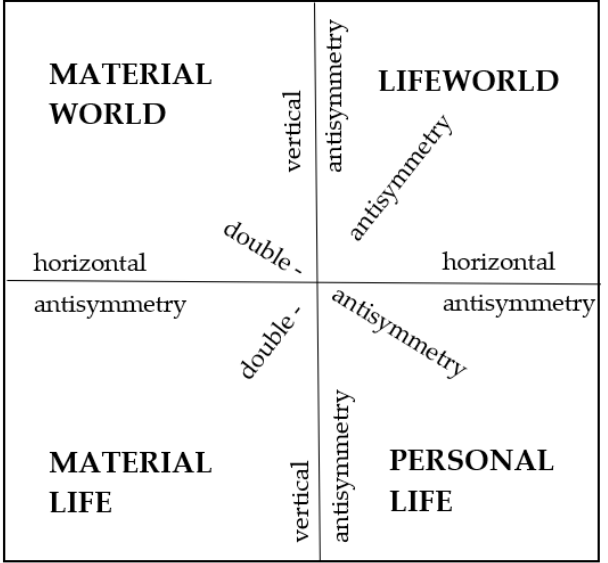
Figure 2. Four layers of Reality and their antisymmetric relations.